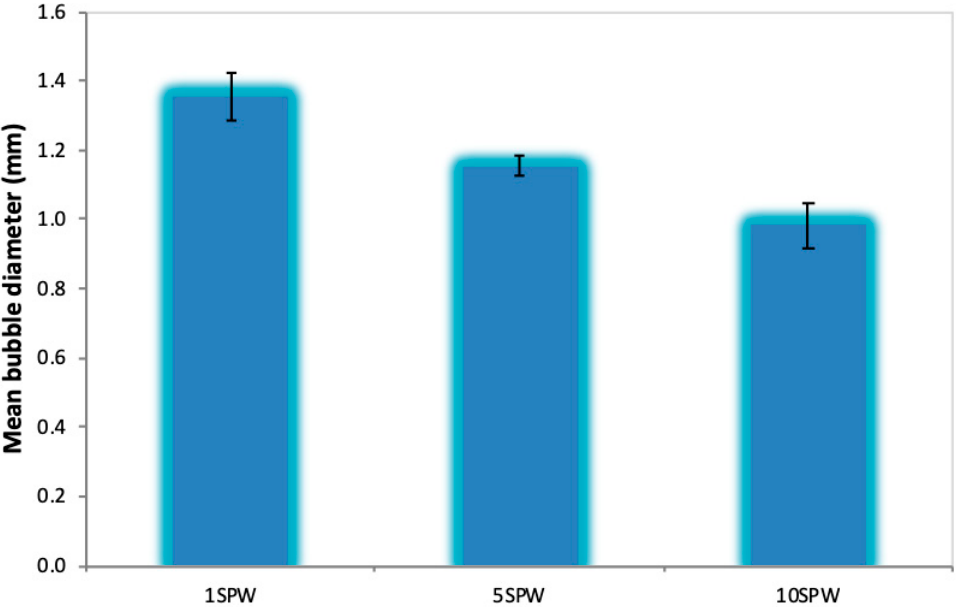
Figure 14. Pulp bubble diameter as a function of the ionic strength of SPW adapted from Manono et al. [32].